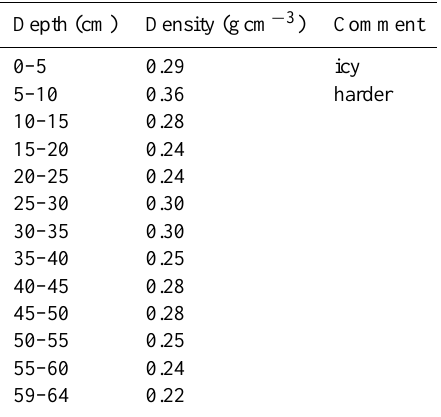
snow near the FIGIFIGO spot. Table 5. The snow density profile, measured at the airport near the FIGIFIGO spot on 5 April